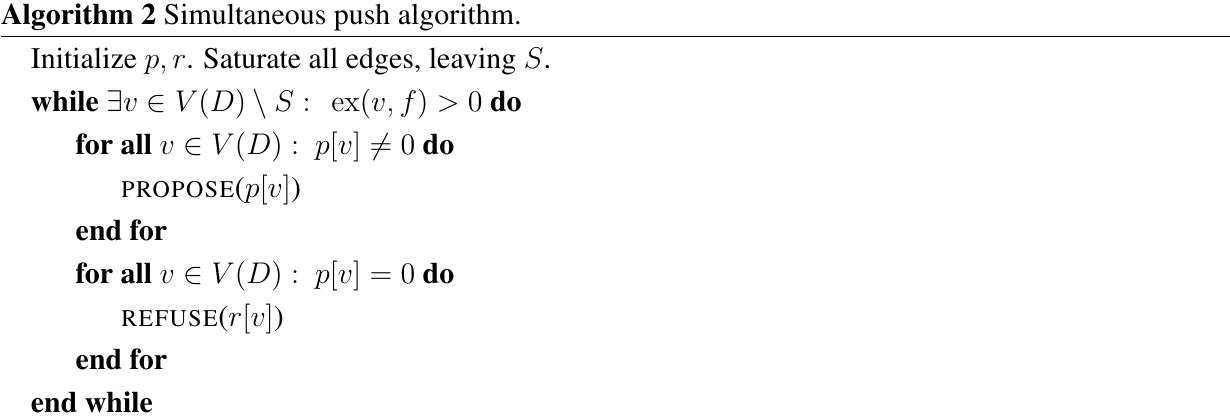
Algorithm 2 Simultaneous push